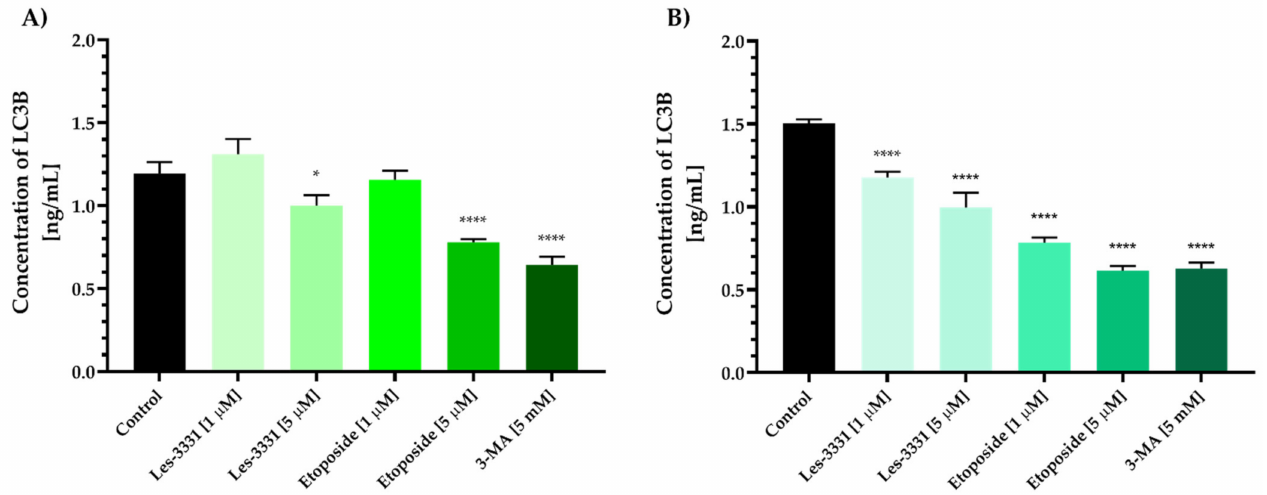
Figure 9. The concentration of LC3B in MCF-7 ( A ) and MDA-MB-231 ( B ) human breast cancer cells after 24 h incubation with Les-3331 and reference drug (etoposide) at 1 µ M and 5 µ M concentration. As a positive control, 3-Methyladenine (3-MA), a known autophagy inhibitor, in 5 mM concentration was used. Mean ± SD from three independent experiments performed in duplicate is presented. Statistical significance was calculated using one-way ANOVA with Bonferroni multiple comparison test. Differences were considered statistically significant at: * ( p ≤ 0.05), **** ( p ≤